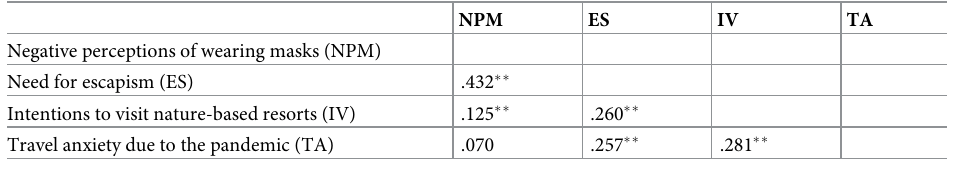
Table 3. Variable correlates.